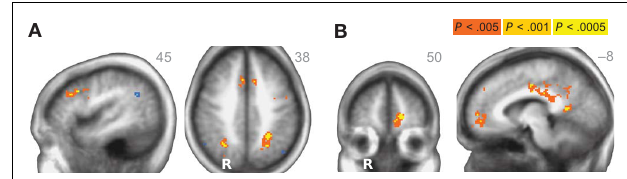
FIGURE 2 | (A) δ -related neural activity in the bilateral anterior insula, dorsolateral prefrontal cortex, and bilateral parietal cortex across all subjects. (B) β -related neural activity in the medial prefrontal cortex, orbitofrontal cortex, and posterior cingulate across all subjects. R = right. R/L, A/P, or S/I value listed in upper right corner of each statistical map. Anatomical underlay is an average of all subjects’ spatially normalized structural